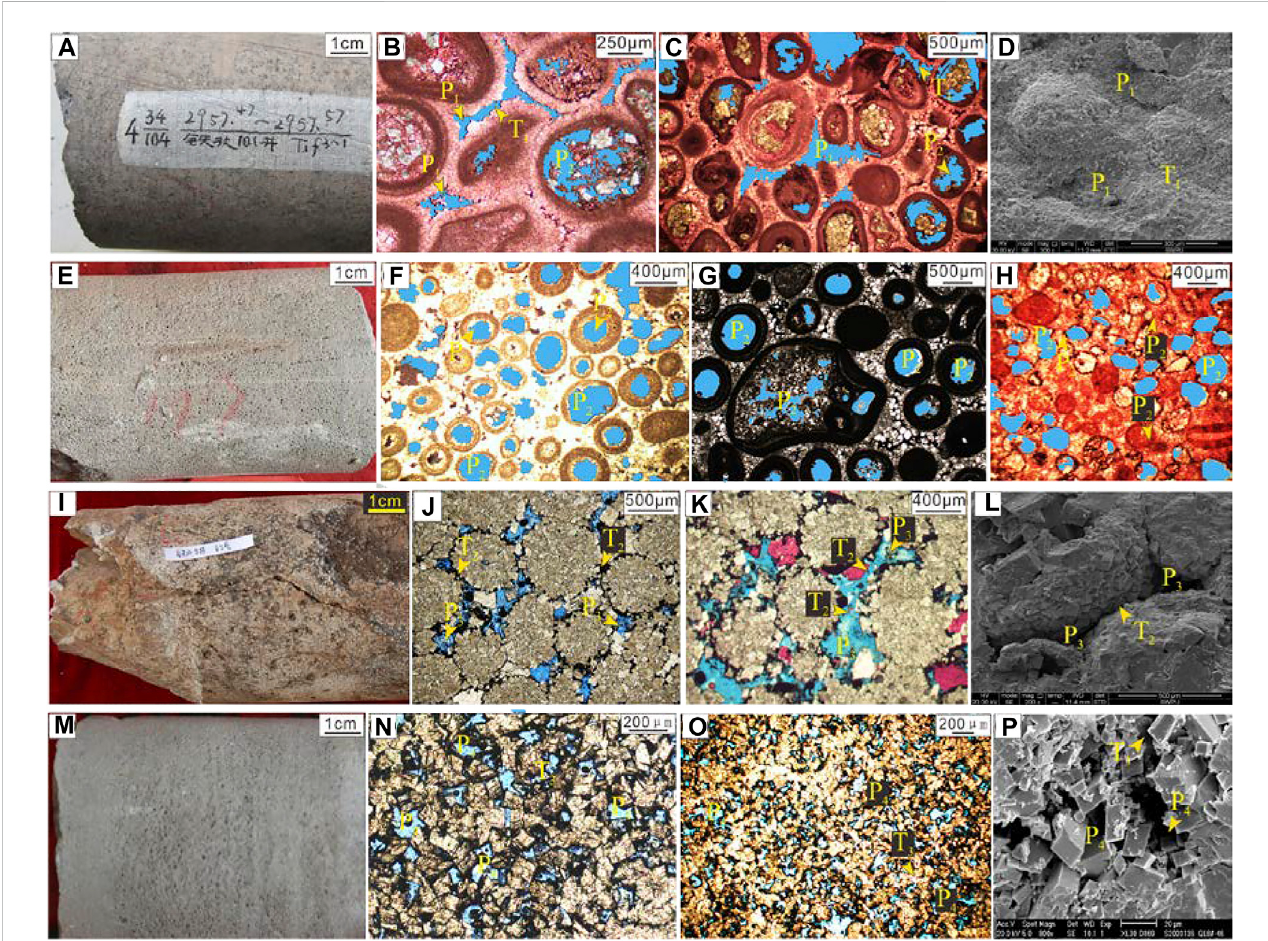
FIGURE 3 Petrological characteristics of different lithofacies in Feixianguan Formation tight oolitic reservoir. (A) Intergranular pores (P 1 ) present as clearly visible pinholesinthedrillcore,LithofaciesA,WellTB101,2957.47 m – 2957.57 m; (B) severalintergranularpores(P 1 )areconnectedthroughtube-shapedthroats(T 1 ), Lithofacies A, Well TB101, 2,956.84 m (PPL); (C) intergranularpores(P 1 ) are connected through tube-shaped throats (T 1 ), Lithofacies A, Well TD110, 3,457.3 m (PPL); (D) intergranular pores (P 1 ), Lithofacies A, Well TD110, 3,457.3 m (SEM); (E) mold pores (P 2 ) without throats, Lithofacies B, Well C10; (F) mold